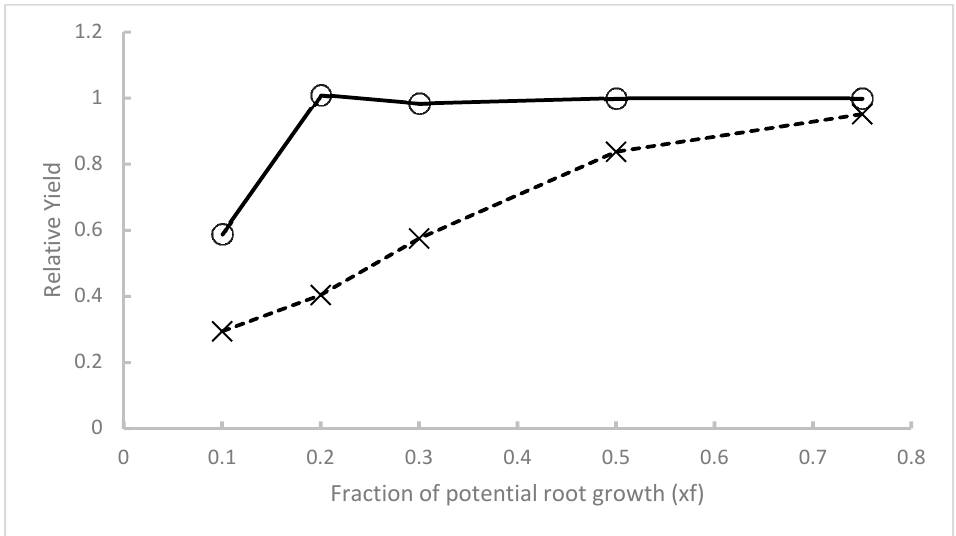
Figure 1. Examples of the relative yield (RY) with decreasing xf (or reducing severity of root reduction) showing a flat response in 1991 (O) and a sharp response in 2000 (X). Data for a sandy soil at Bodallin (WA) with acidity at 0–0.3 m depth.